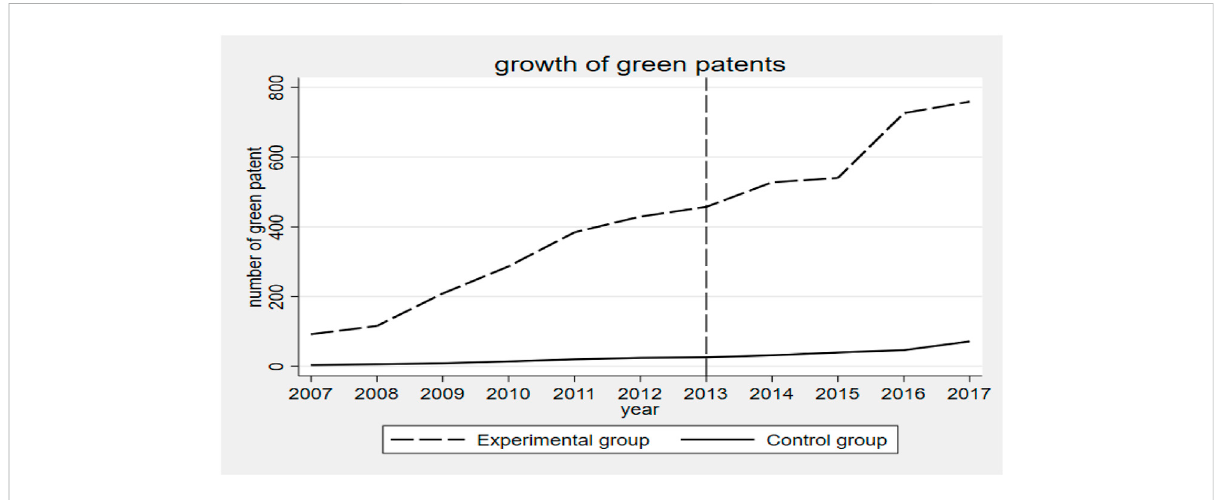
FIGURE 1 Parallel trend test of low carbon city pilot